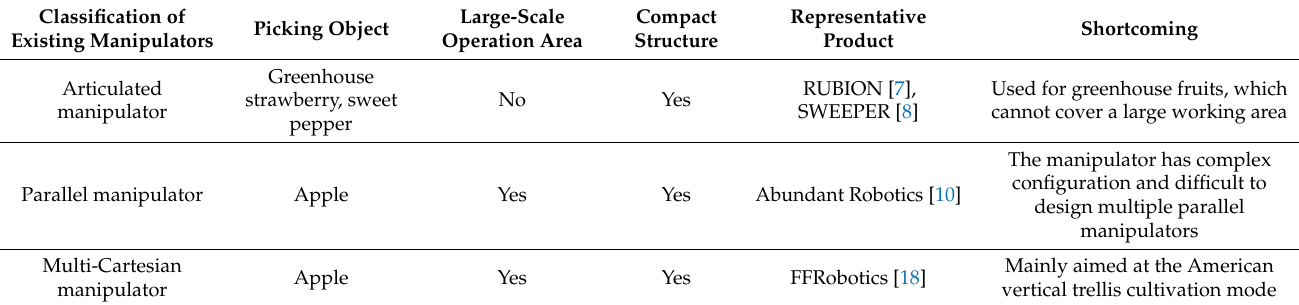
Table 1. A table with shortcomings in representative manipulators and